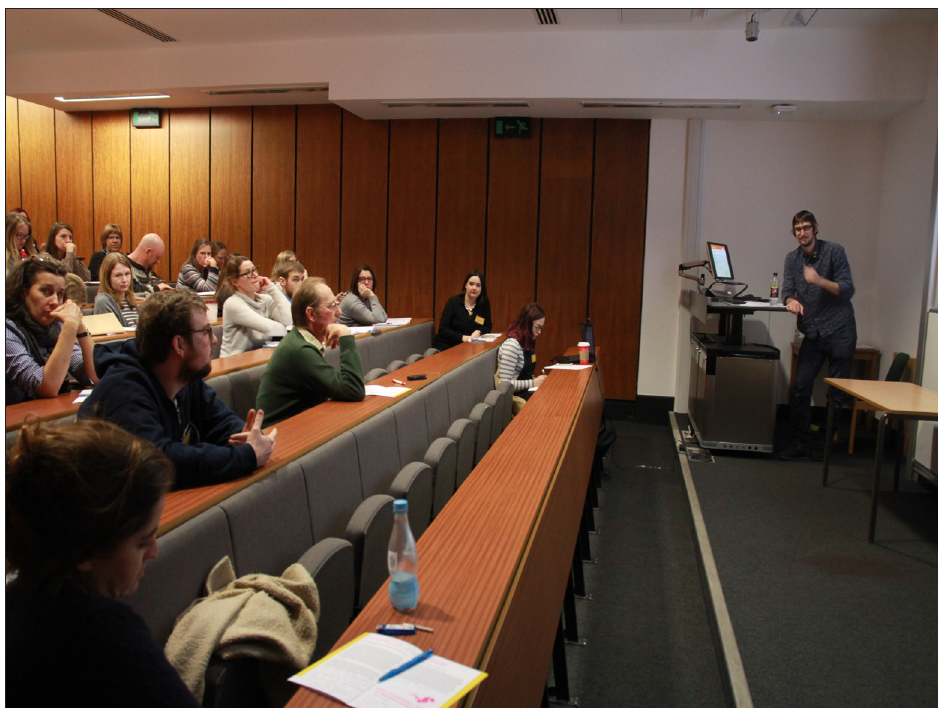
Figure 2: Barney Harris delivers his paper on Saturday morning: Renfrew Reloaded (Photo credit: Muyang